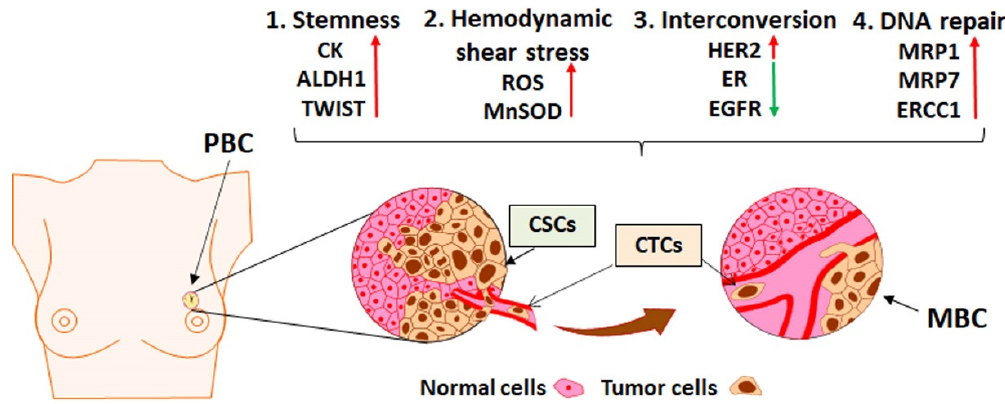
Figure 2. Chemoresistance of CTCs in metastatic breast cancer (MBC). The four mechanisms that underline CTC chemo- resistance in MBC patients include (1) DNA Repair activation (upregulation of MRP1, MRP7 and ERCC1); (2) Stemness phenotype, characterized by activation of EMT factors (CK, ALDK1 and TWIST); (3) Hemodynamic shear stress, charac- terized by generation of ROS and expression of MnSOD; (4) Interconversion of Her2, ER, and EGFR expression in CTCs compared to the primary breast cancer (PBC).